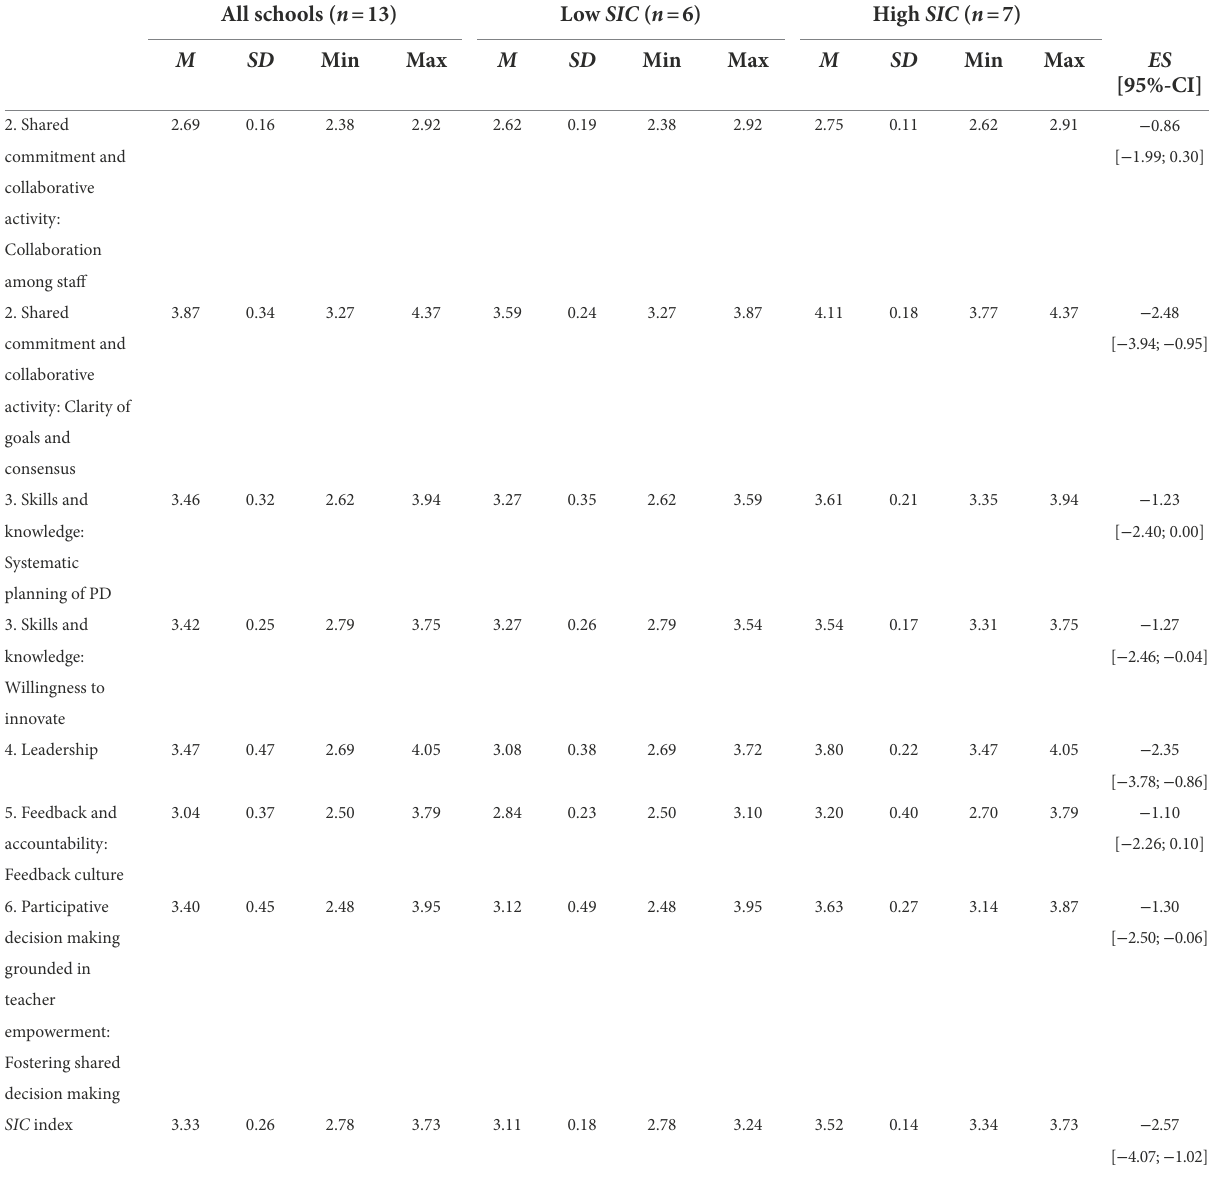
TABLE 3 Group comparison between schools with low and high SIC